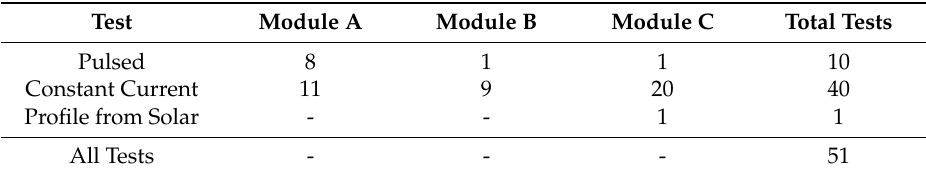
Table 1. Number of tests per module.